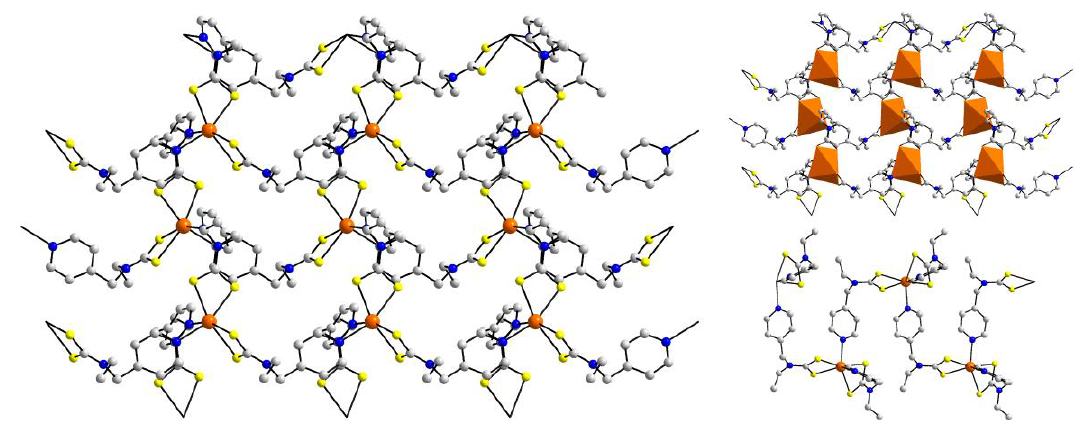
Figure 9. Plan and side-on views of the two-dimensional array in the crystals of [Cd(L 14 ) 2 ] n ( 30 ); one of the plan views highlights the relative disposition of the cadmium atom coordination polyhedra.